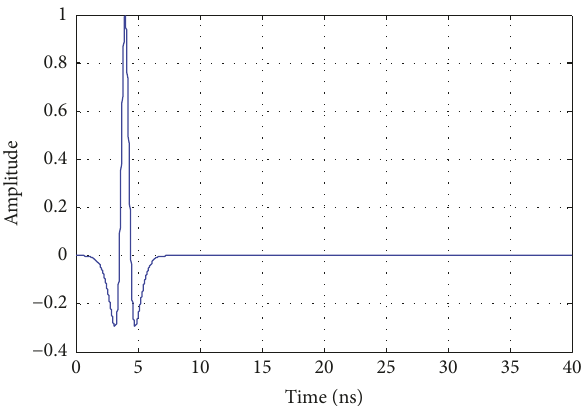
Figure 3: UWB Ricker pulse